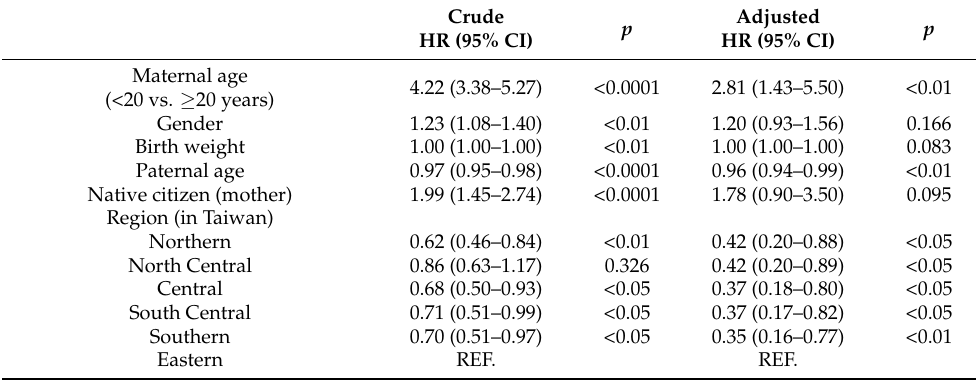
Table 2. Predictions for the occurrence of SIDS using multiple